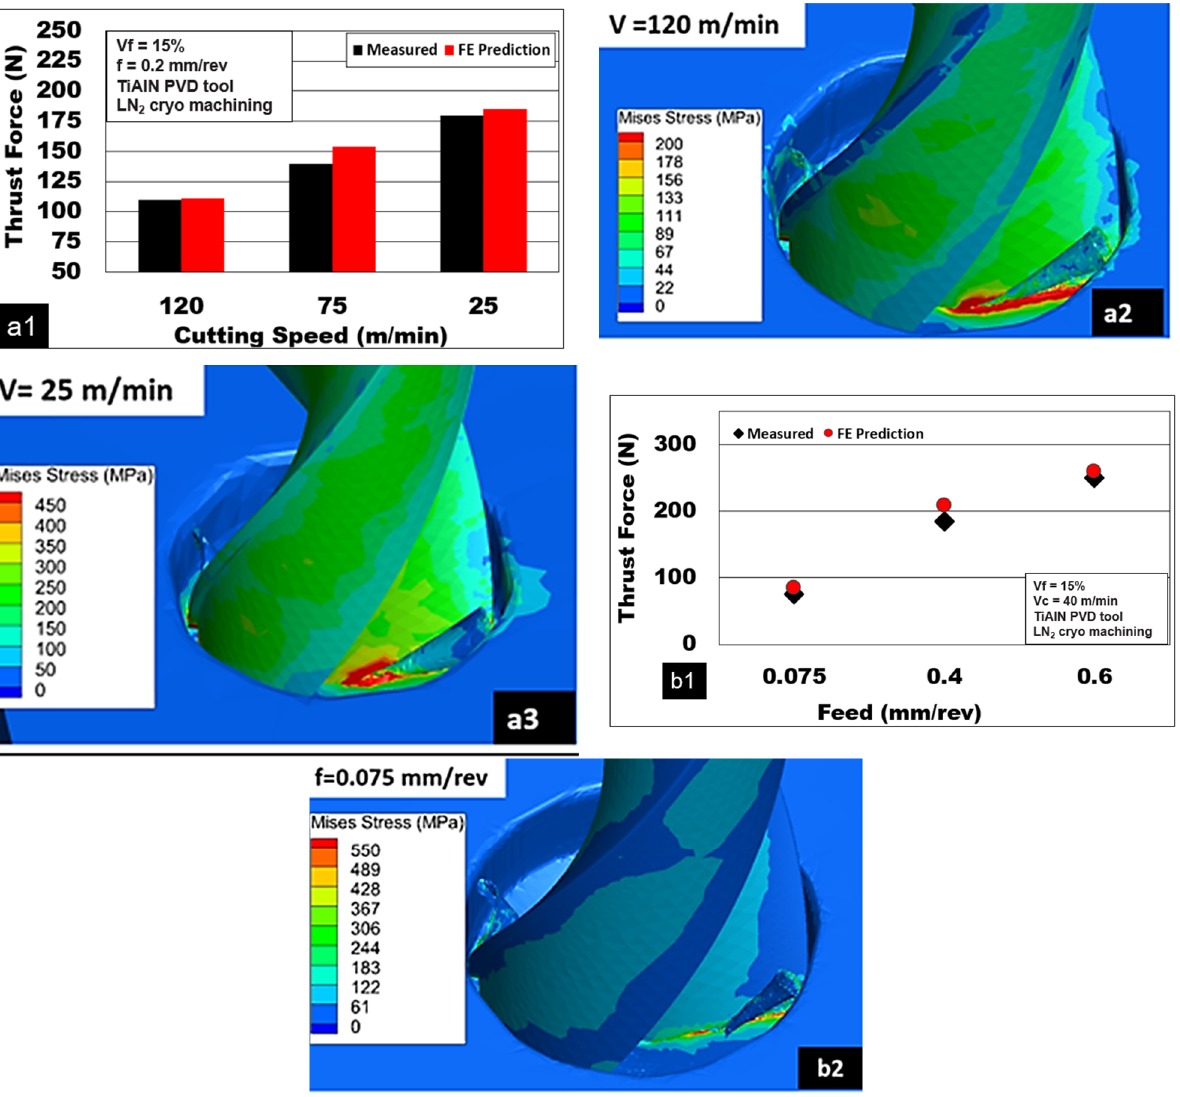
Figure 4. Effect of process parameters during machining Mg-9Al-1.4Zn-15% hollow Al 2 O 3 foam: ( a1 ) effect of cutting speed, comparison between experiment and FE prediction; ( a2,a3 ) von Mises stress distribution for V C = 125 m/min and V C = 25 m/min; ( b1 ) force comparison between experiment and FE prediction for feed conditions; ( b2 ) von Mises stress distribution for feed = 0.075 mm/rev (coated drill, cryogenic cooling).